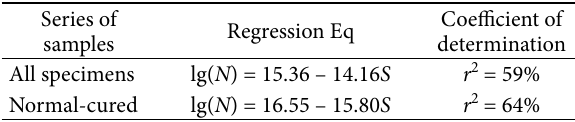
Table 2. Results of the regression